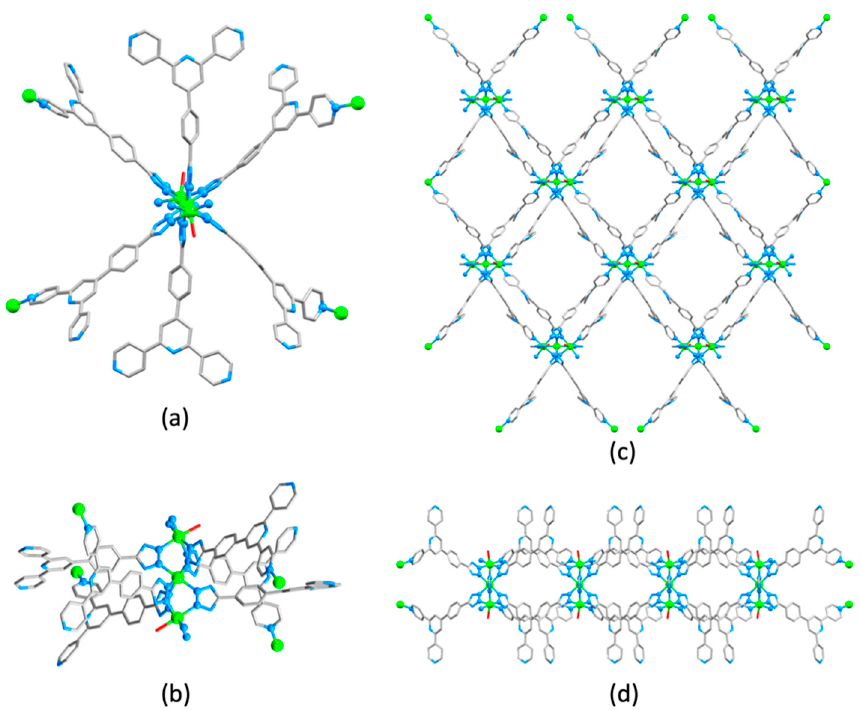
Figure 28. The structure of [Zn 3 ( 46 ) 6 (OH 2 ) 2 ] n · 2H 2 O (CSD refcode NUBZUI). Two views of the {Zn 3 ( 46 ) 6 (OH 2 ) 2 } building block showing (a) four coordinating and two non ‐ coordinating 4,2’:6’,4” ‐ tpy units, and (b) the {Zn 3 ( μ‐ triazolato) 6 } node. Part of one 2D ‐ network, viewed (c) down the crys ‐ tallographic c ‐ axis, and (d) down the a ‐ axis; the non ‐ coordinated 4,2’:6’,4” ‐ tpy units with their phenylene spacers are omitted for clarity.